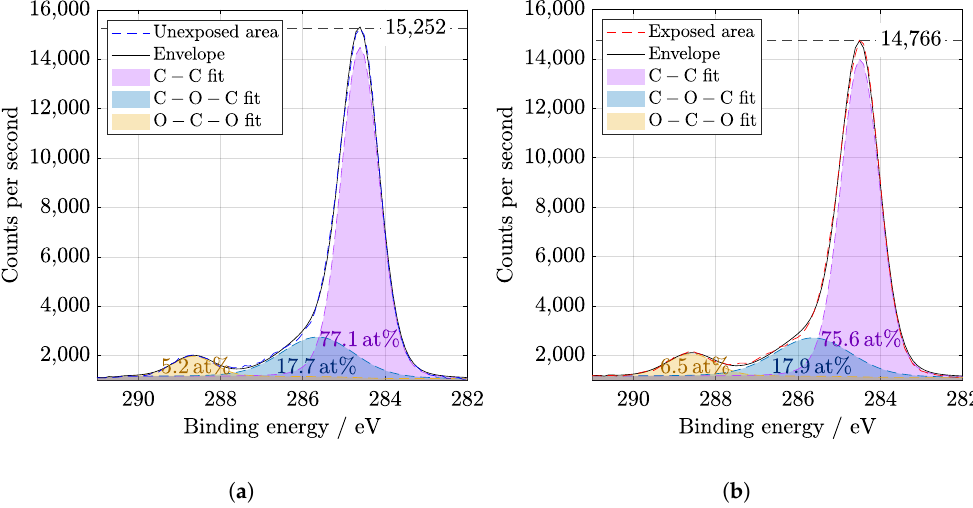
Figure 6. High resolution of C1s region from XPS ( a ) before and ( b ) after SL irradiation of 67 days. Binding energy value for C − C is 284.6 eV, for C − O − C is 285.6 eV, and for O − C − O is 288.6 eV. An increase of last two mentioned bonds is